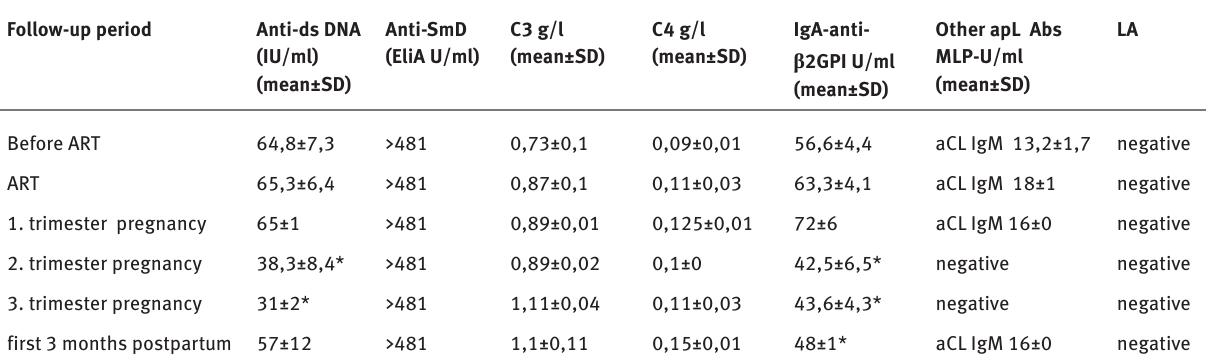
Figure 2 : Course of anti-dsDNA (squares) and IgA- β 2GPI (triangles) antibodies in the patient. The figure shows titers of anti-ds DNA (IU/ml) and IgA-β2GPI (U/ml) antibodies during different checkpoints of the follow-up compared to each other. Threshold for high positivity (dotted line) was ≥40 IgA-antiβ2GPI U/ml. Bars represent standard deviations of the means. (*: P<0.05). Abbreviations: ART: assistant reproductive Table 1: Laboratory data of the patient